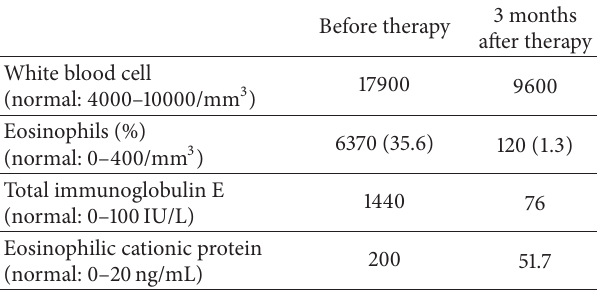
Table 1: Laboratory results of the patient before and after steroid